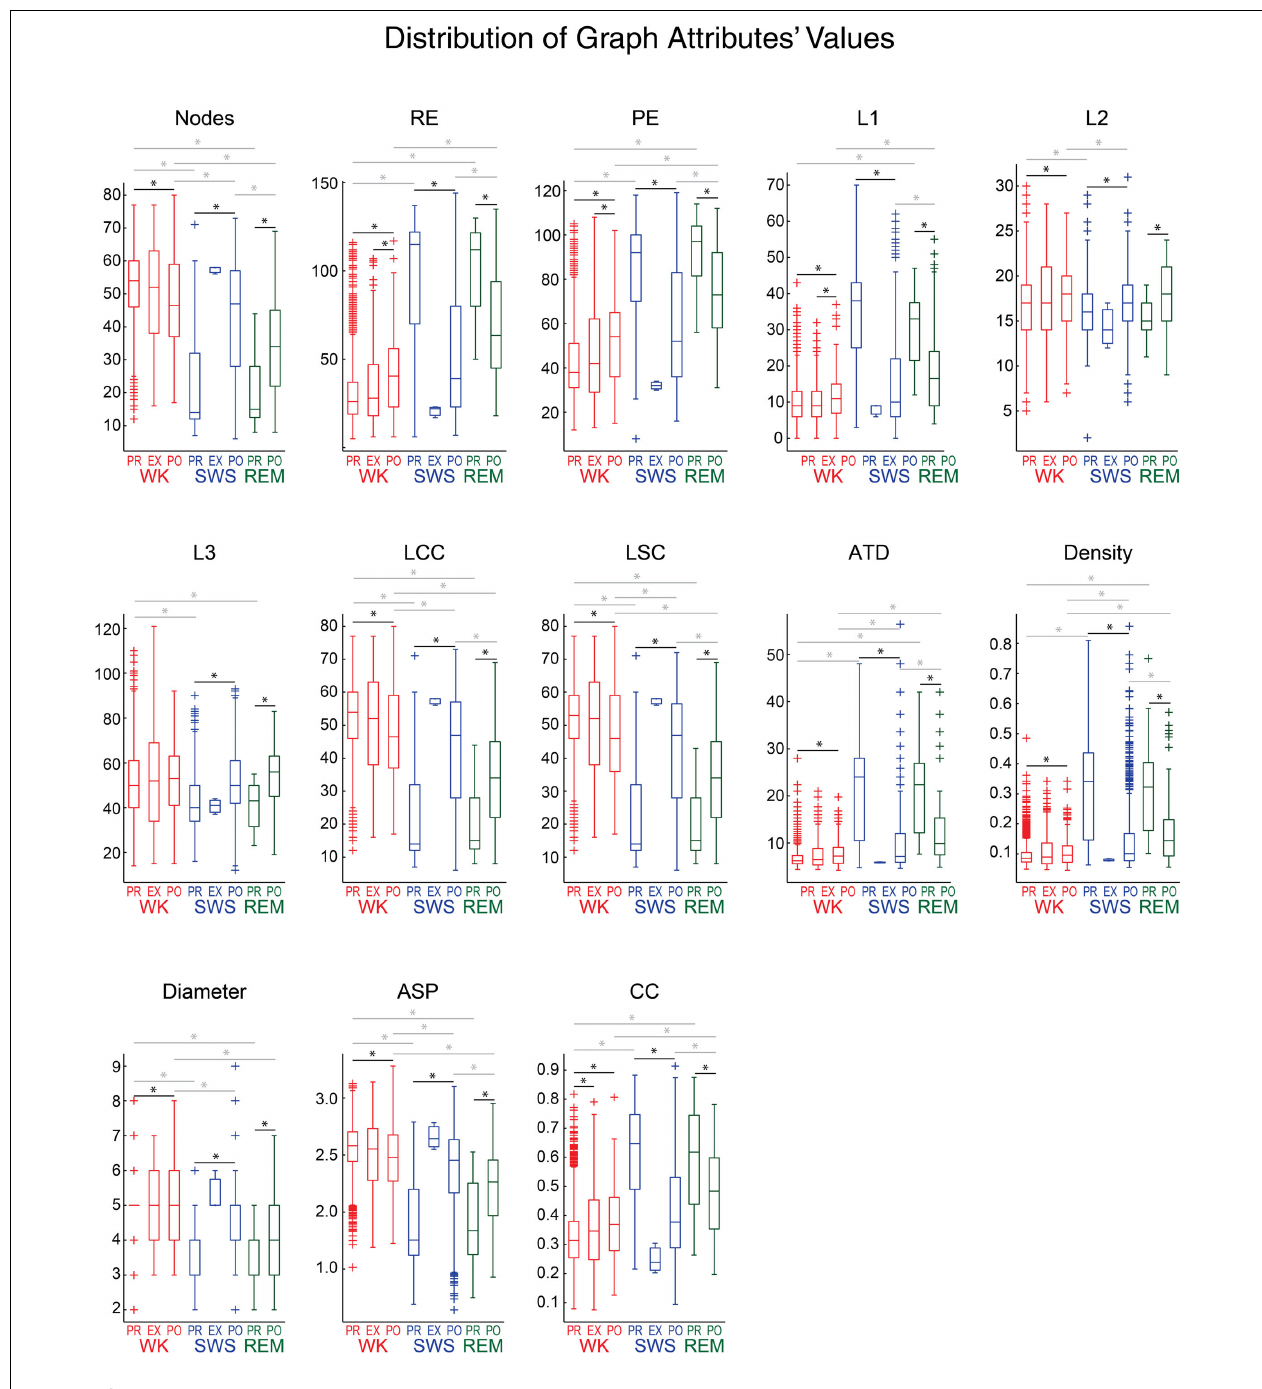
behavioral states within a given experimental period. Note that nearly all the attributes sorted WK from SWS, during PRE or POST (except for L1 during PRE and L3 during POST). WK was significantly different from REM during PRE (12 attributes) and POST (11 attributes), SWS was significantly different from REM during POST (10 attributes), but no attribute could sort SWS and REM during PRE. Only one attribute was capable of sorting PRE from EXP within WK. When comparing PRE × POST within WK, 12 attributes could separate them. EXP WK graphs were detected as different from POST WK graphs by 3 attributes. PRE SWS could be sorted from POST SWS, and PRE REM could be sorted from POST REM, using any of the graph attributes